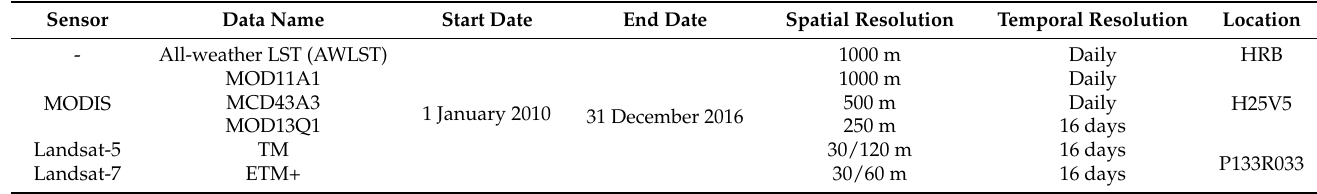
Table 1. Information of multi-platform satellite remote sensing